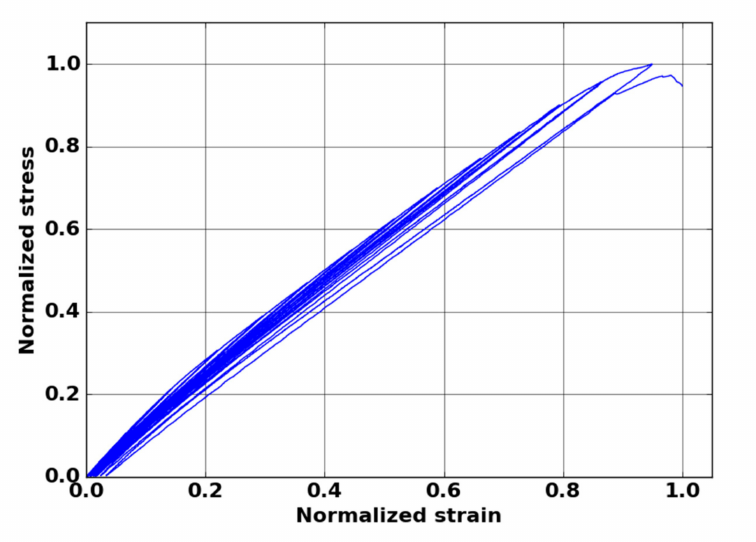
Figure 7. Descriptors calculated in the frequency domain on a digitized AE signal.